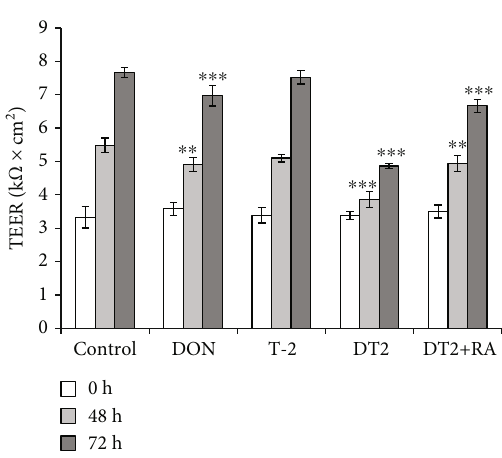
Figure 4: The changes of H O production after incubation of 2 2 IPEC-J2 cells with 1 μ mol/L DON, 5 nmol/L T-2, DT2 ( 1 μ mol/L DON + 5nmol/L T − 2 ), and DT2 + RA ( 1 μ mol/LDON + 5nmol/L T − 2 + 50 μ mol/LRA ) (24h preincubation) for indicated time periods (48h and 72h). ∗∗∗ p < 0 : 001 compared to the control values. Data are presented as means ± SD ( n = 8